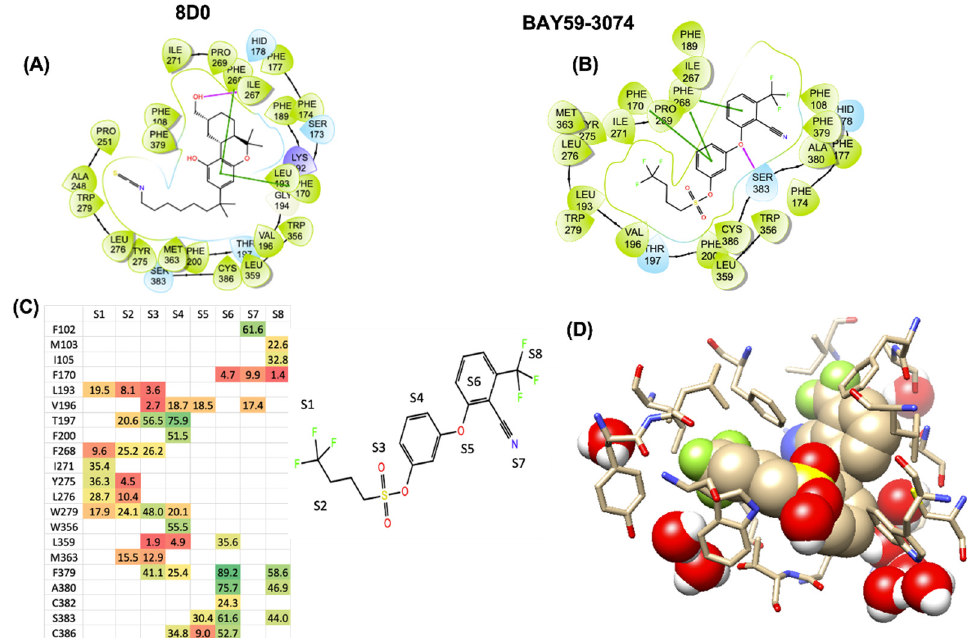
Figure 2. The LIGPLOT representations for the best Emodel scored induced-fit/GLIDE-XP docking poses of ( A ) agonist 8D0(AM841), and ( B ) compound 1 shows that they thread the largely hydrophobic CB1 binding site in a similar manner. The top MMGBSA-scored docking poses from Schrodinger’s induced fit/GLIDE-XP and Autodock VINA show π -stacking with F268 ECL2 and F170 2.57 ( C ) The color-coded heat-map contact-analysis for the 850 ns molecular dynamic simulation reveals that while the sulfonyl (S3-region) of 1 spends significant percentages of total simulation time (heatmap) proximate to T197 3.33 and W279 5.43 , direct H-bond/polar interactions with these polar residues is not persistent. Instead, bridged polar-residue—water H-bond stabilization is observed between these residues and the ligand sulfonyl. The heat-map spectrum is coded from green (high percentages) to red (low percentages). Panel ( D ) shows a 840 ns snapshot of 1 CB1 in DOPC/KCL/TIPS3P water from the 850 ns simulation highlighting these water bridging